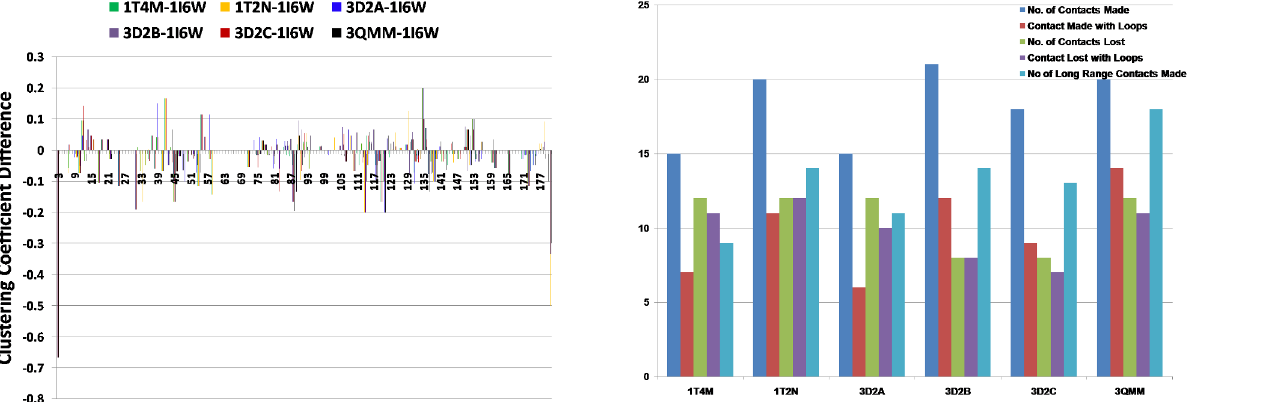
Figure 4. Residue-wise difference between the CC values of the mutants and WT.